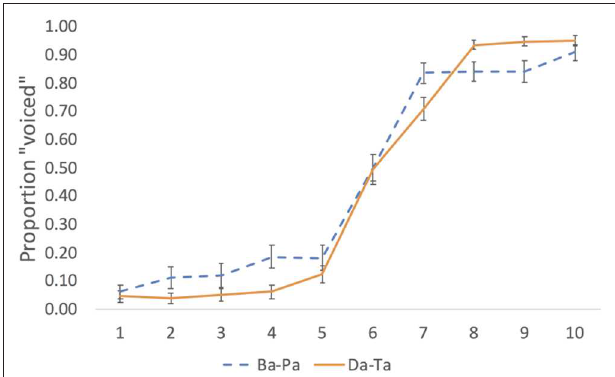
FIGURE 1 | Pilot identification results for the labial (Ba-Pa) and coronal (Da-Ta) voicing continua. Error bar are standard errors of the